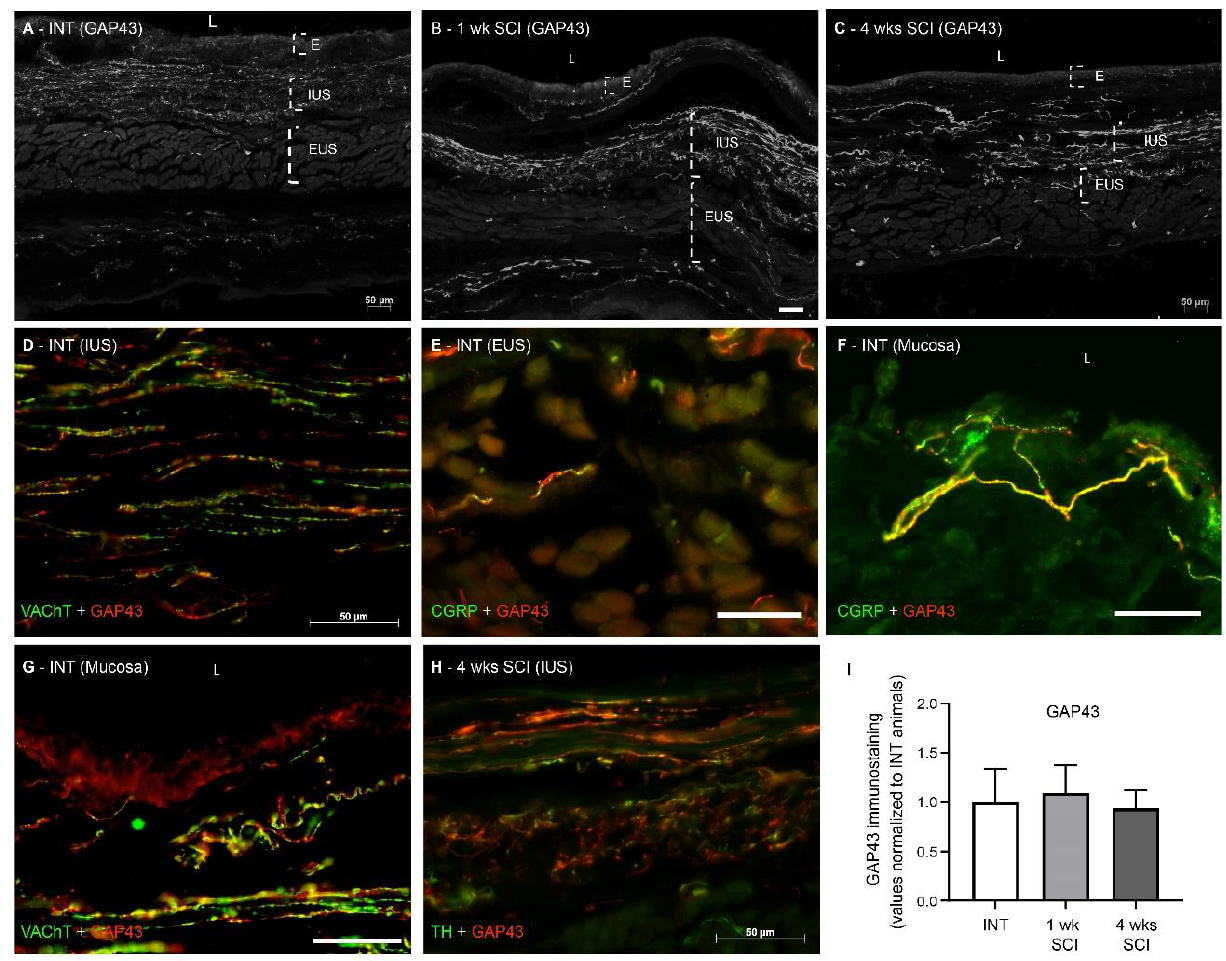
Figure 9. Immunolabeling of GAP-43 in the proximal urethra. The existence of neuronal sprouting was assessed by immunohistochemistry against Anti-Growth Associated Protein-43 (GAP-43), which stains sprouting axons. GAP43 was abundantly expressed in urethral sections from intact ( A ), 1-week ( B ) and 4-weeks post-SCI animals ( C ). The co-localization of GAP-43 with all markers of nerve fibres was observed ( D – H ), irrespective of the time point of disease progression and location within the urethral wall. We found no significant differences in GAP-43 content ( I ), irrespective of the time point of disease progression. Scale bars equal 50 μm. The quantification of labelling intensity by Image J in the extension of the proximal urethra ( n = 4). One-way ANOVA followed by Tukey’s multiple comparison test.